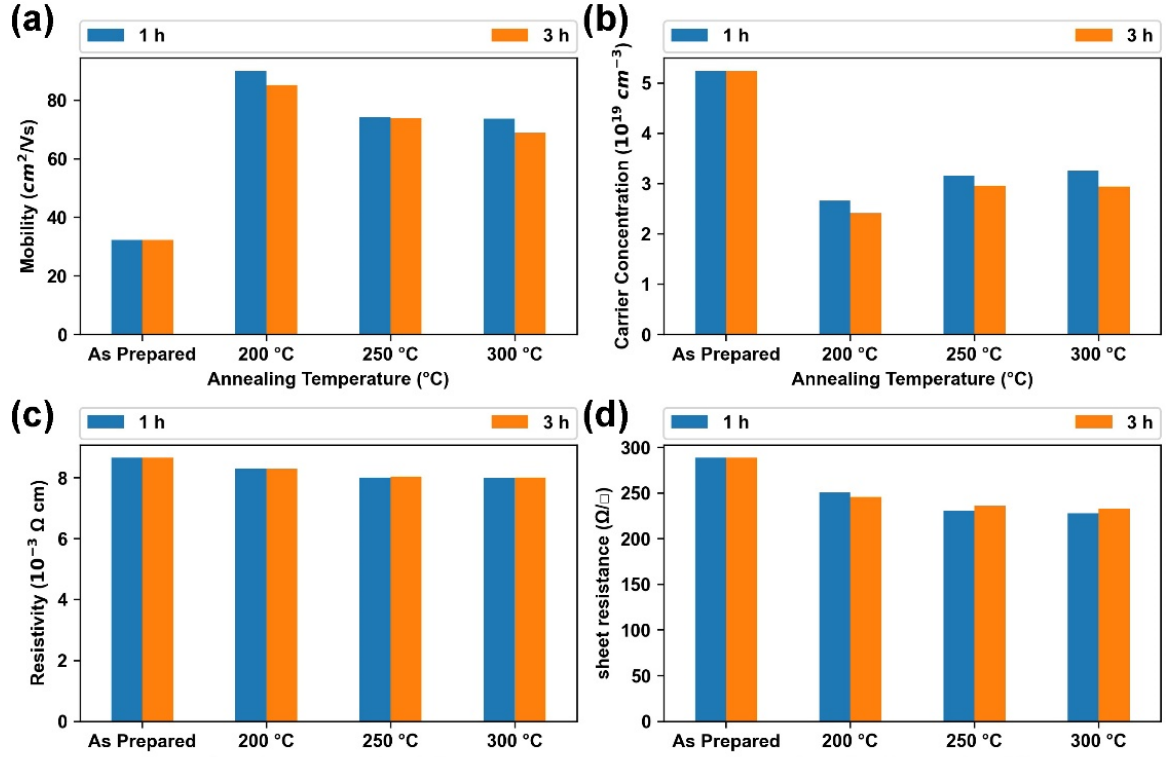
Figure 9. Electrical properties with annealing temperature: carrier mobility ( a ), carrier concentration ( b ), resistivity ( c ), and sheet resistance ( d ).